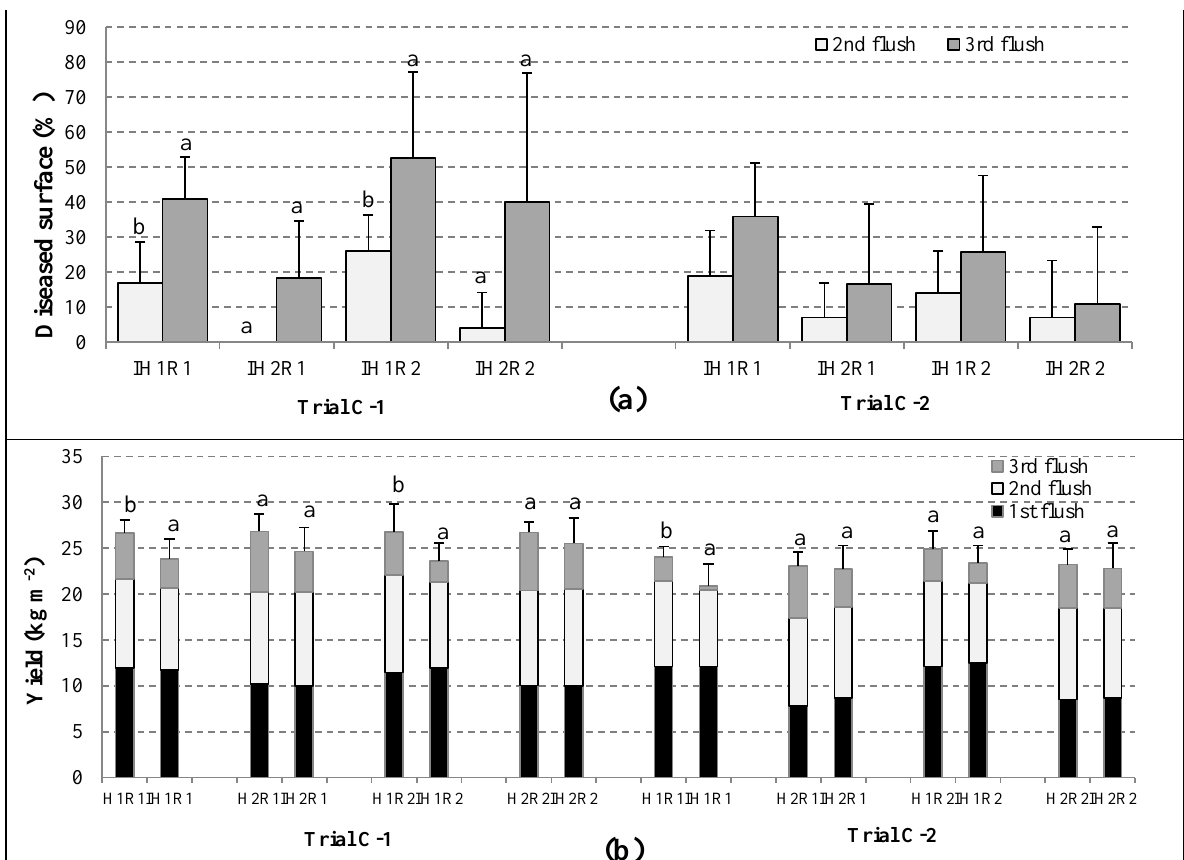
Figure 3. Pathogenic with artificial infection of Cladobotryum mycophilum (C-1 and C-2). ( a ) Incidence; ( b ) Yield. H1R1, low initial water content with a light irrigation program; H2R1, high initial water content with a light irrigation program; H1R2, low initial water content with a moderate irrigation program; H2R2, high initial water content with a moderate irrigation program. I in treatment means artificially inoculated with the parasite. (*) For each trial and flush, the same letters show no significant differences according to Tukey’s HSD test at p = 0.05.